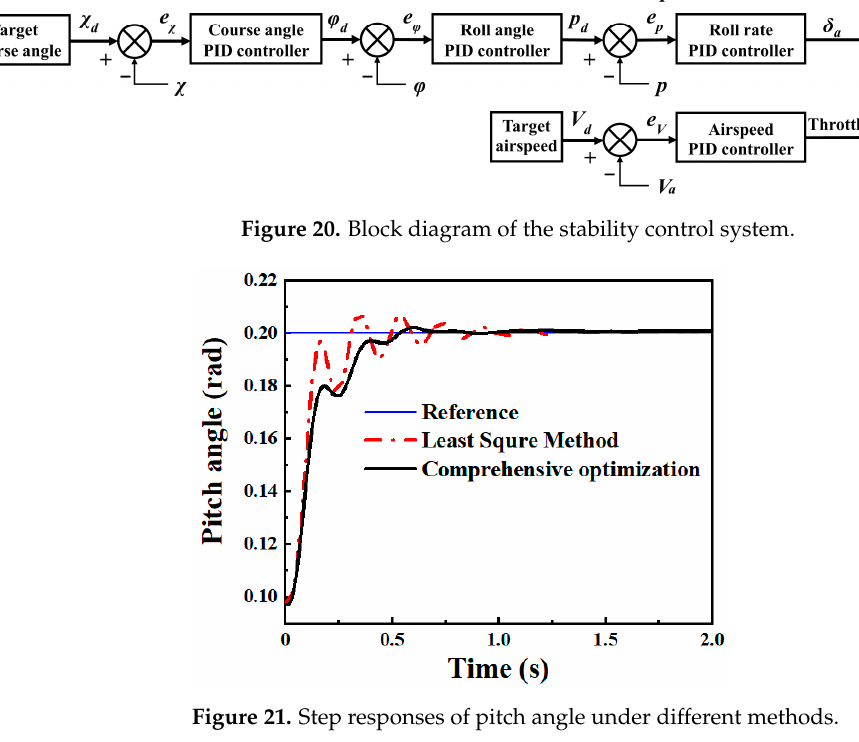
Figure 21. Step responses of pitch angle under different methods.